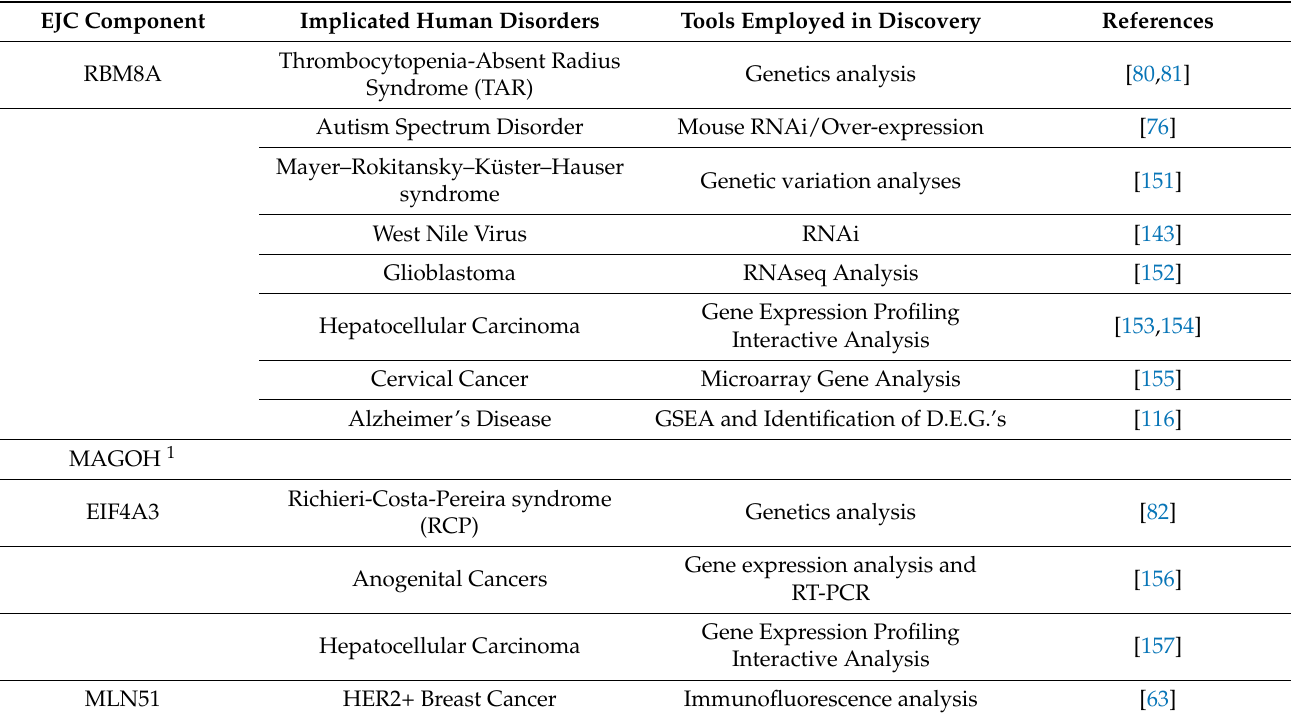
Table 2. Core EJC Components and associated human disorders. Methodology in which the associa- tion was made between the EJC core component, and the human disorder is summarized accordingly as the tool employed in discovery. References are provided for the publications establishing the relevant